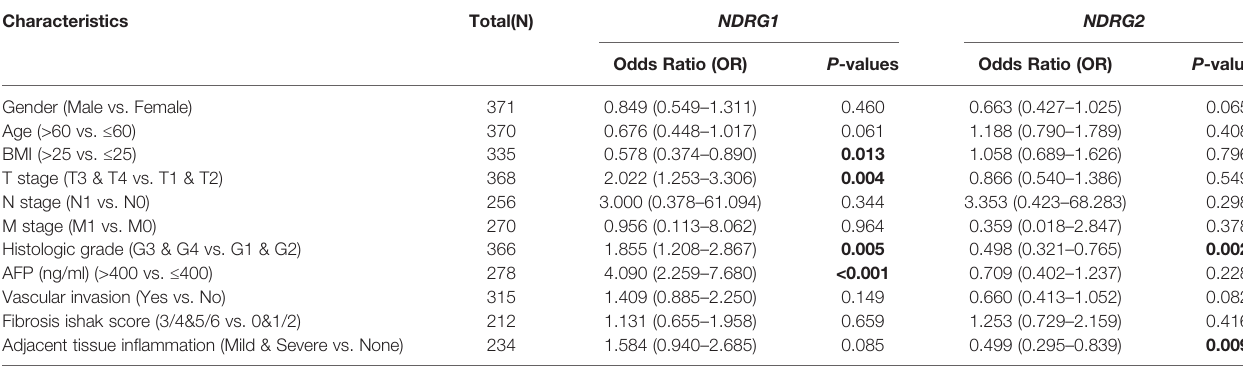
Bold indicates signi fi cant